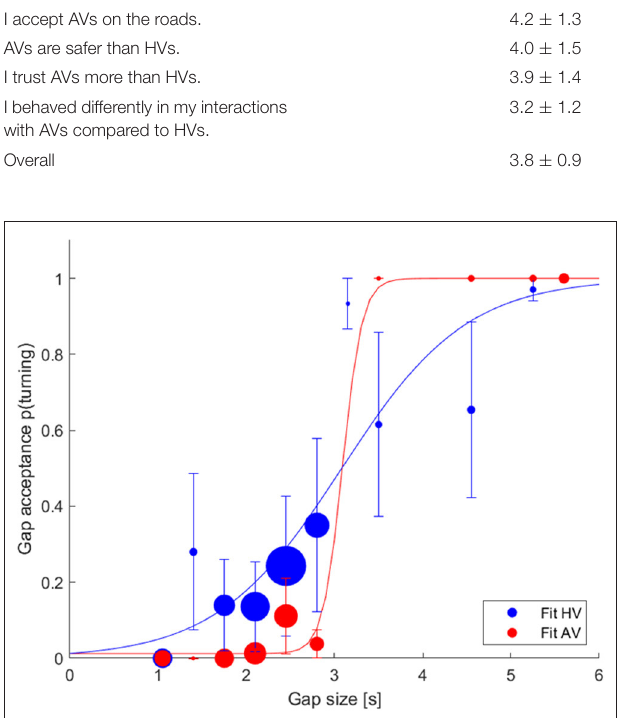
FIGURE 4 | Gap acceptance vs. gap size over all participants for HV (blue) and AV (red). The marker size represents the total number of events for the corresponding gap size. A logistic model was fit to each